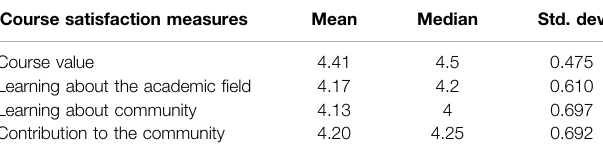
TABLE 2| Descriptive datainthewholesample( N (cid:1) 245) onthefoursubscalesof the SL-based course satisfaction